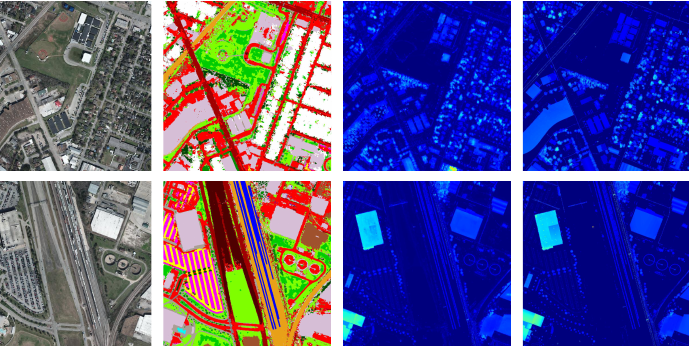
Figure 14. Part of the area on the DFC2018 dataset. The first and last columns are the input RGB image and the relative height map of the corresponding area, and the second and third columns are the classification map and the relative height prediction results of the model output, respectively.